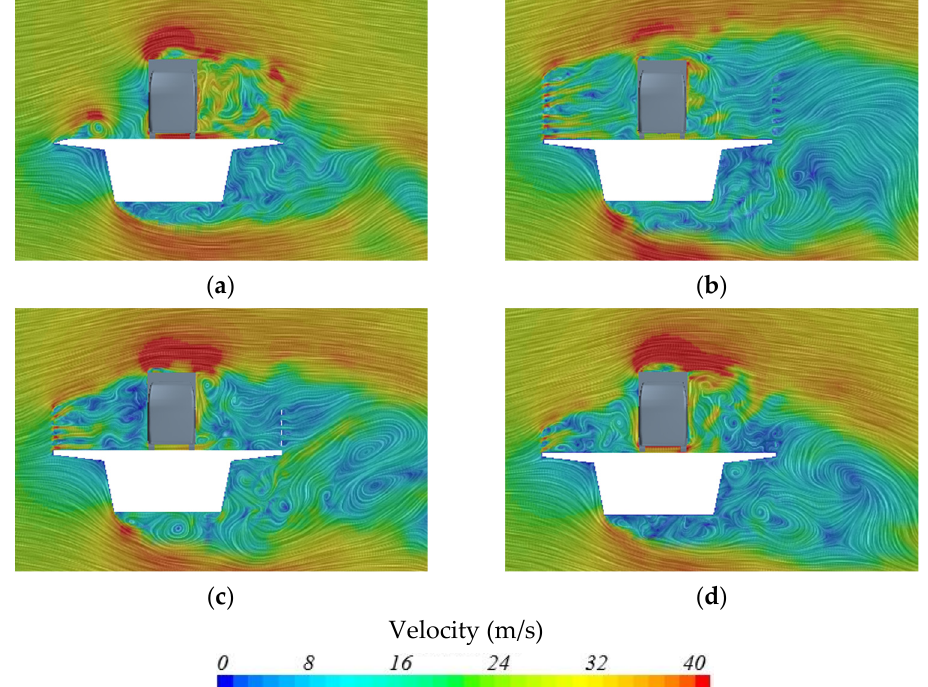
Figure 8. Velocity distribution for different height schemes (( a ) Bare bridge; ( b ) Scheme 2-1; ( c ) Scheme 2-2; ( d ) Scheme 2-3).